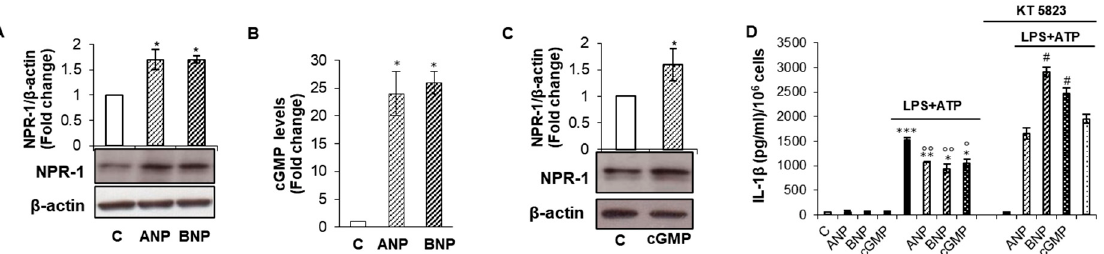
Figure 1. Cyclic Guanossine monophosphate (cGMP)/Protein kinase G—I (PKG-I) axis drives Atrial natriuretic peptide (ANP)/ B-type natriuretic peptide (BNP) inhibitory effect on Interleukin (IL)-1 β secretion. THP-1 cells were treated with ANP or BNP (10 − 8 M) ( A , B ) or 8-Br-cGMP (100 µ M) ( C ) for 1 h ( A , C ) or 30 min ( B ). ( A , C ) NPR-1 protein expression by Western blot. Protein loading was assessed by re-probing the blots with an anti- β -actin antibody. Western blots are representative of n = 3 independent experiments. ( B ) Cells were lysed, and cGMP intracellular levels were measured by ELISA assay (basal cGMP: 64 fmol/10 6 cells). ( D ) THP-1 cells, either pretreated for 10 min with ANP or BNP (10 − 8 M) or 8-Br-cGMP (100 µ M) or left untreated, were exposed to LPS (10 µ g/mL) for 20 min and treated with ATP (5 mM) for 48 h. When used, KT-5823 (1 µ M) was added 1 h before ANP, BNP, or cGMP. The supernatants were collected and IL-1 β release was measured by ELISA. All histograms indicate mean ± SD of at least n = three independent experiments, each one tested in triplicate. * p < 0.05, ** p < 0.01, *** p < 0.001 versus untreated control cells; ◦ p < 0.05, ◦◦ p < 0.01, versus LPS + ATP-treated cells; # p < 0.05 versus KT-5823 + LPS + ATP treated cells.